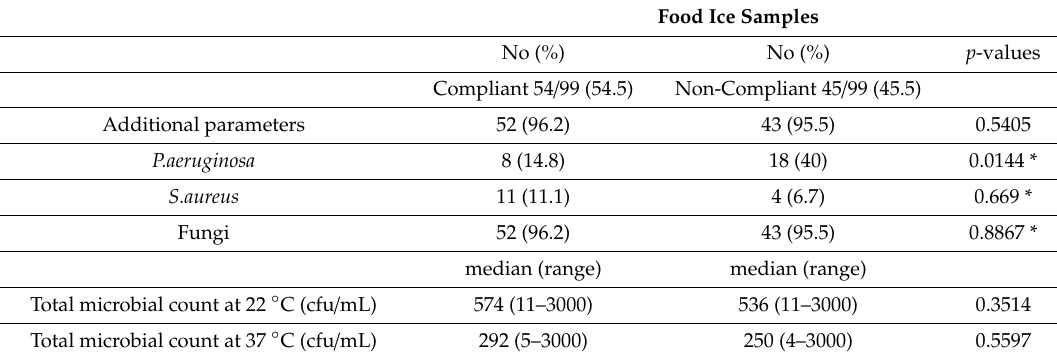
Table 1. Additional parameters investigated in compliant and non-compliant food ice samples.